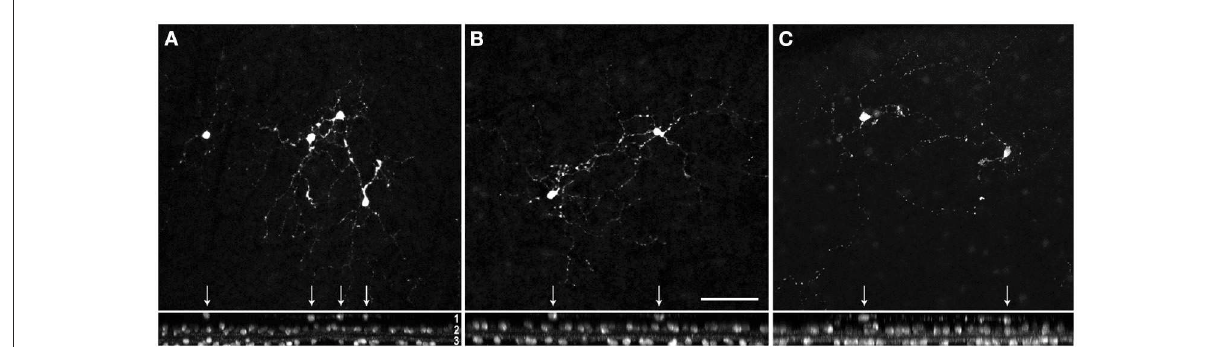
FIGURE3 Misplaced cholinergic amacrine cells in the marmoset retina . Examples of misplaced cholinergic ACs in peripheral retina of a 5 year-old female (A,B) , and 9 year-old female (C) . Z-projections of confocal image stacks are shown in the upper panel, the corresponding xy-projections in the lower panel. Misplaced cells are marked with arrows. Layer 1, somata of the misplaced cells in the outer part of the INL; layer 2, somata of the cholinergic cells in the inner INL (OFF SACs); layer 3, labeled somata in the GCL (ON SACs). Scale in (B) 50 µ m for (A–C) .